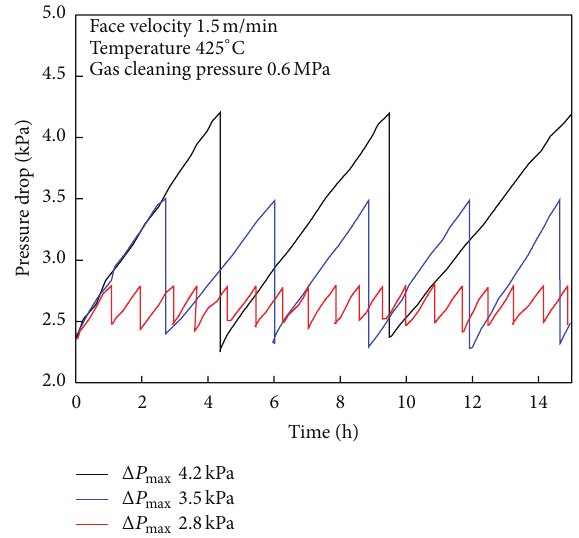
Figure 17: Pressure drop variations for maximum pressure drop of 2.8 kPa, 3.5 kPa, and 4.2